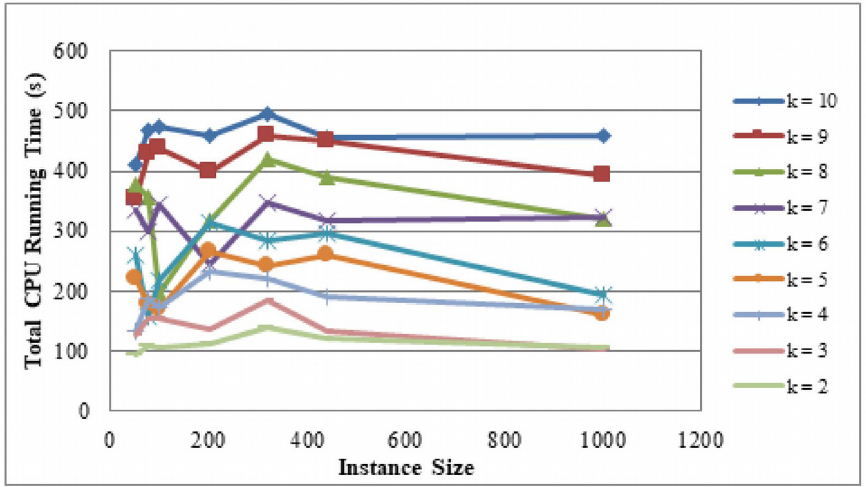
Figure A-5. Total CPU running time vs. instance size for FA-GA